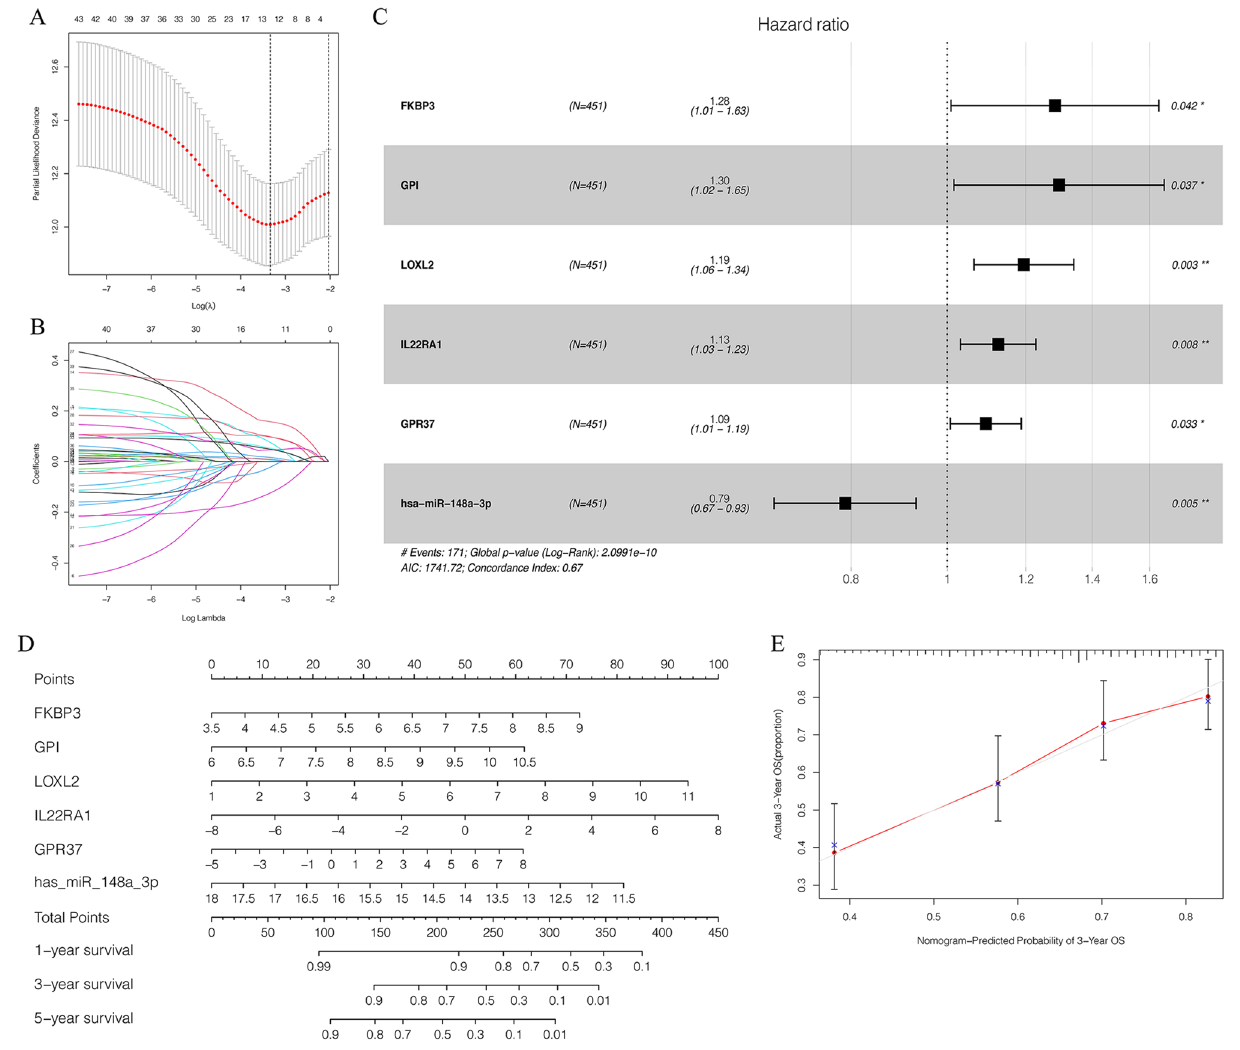
six genes ( FKBP3, GPI, LOXL2, IL22RA1, GPR37 , has-miR-148a-3p ) were as the key gene for constructing the prognostic prediction model, p -value < 0.05. ( D ) The nomogram based on the key genes model, and (E) the calibration curves validated the